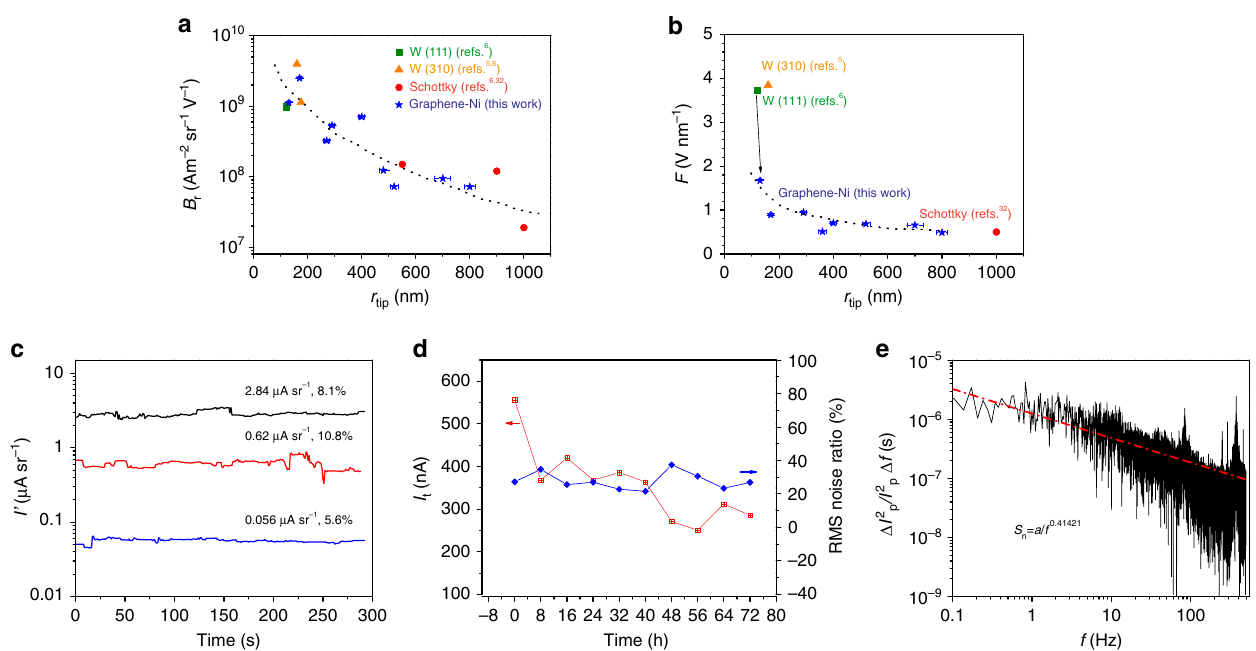
Fig. 4 Electron optical characterization of the Graphene-Ni fi eld emitter. a Comparison of reduced brightness to other fi eld emission sources. b Local electric fi eld strength versus tip radius and the state-of-the-art electron sources. The uncertainty in the x -axis of ( a , b ) is from the determination of tip size. c Short-term current stability curve of the graphene-coated point cathode with a sampling rate of 2 Hz, and the results were obtained in a chamber at a pressure of ~4 × 10 − 8 torr. d The averaged total emission current over each period (8 h) versus time for 3 days (red), and the corresponding RMS noise ratio. e Power spectrum analysis of the probe current (1.5 nA) with a sampling rate of 1 kHz for a time span of 30